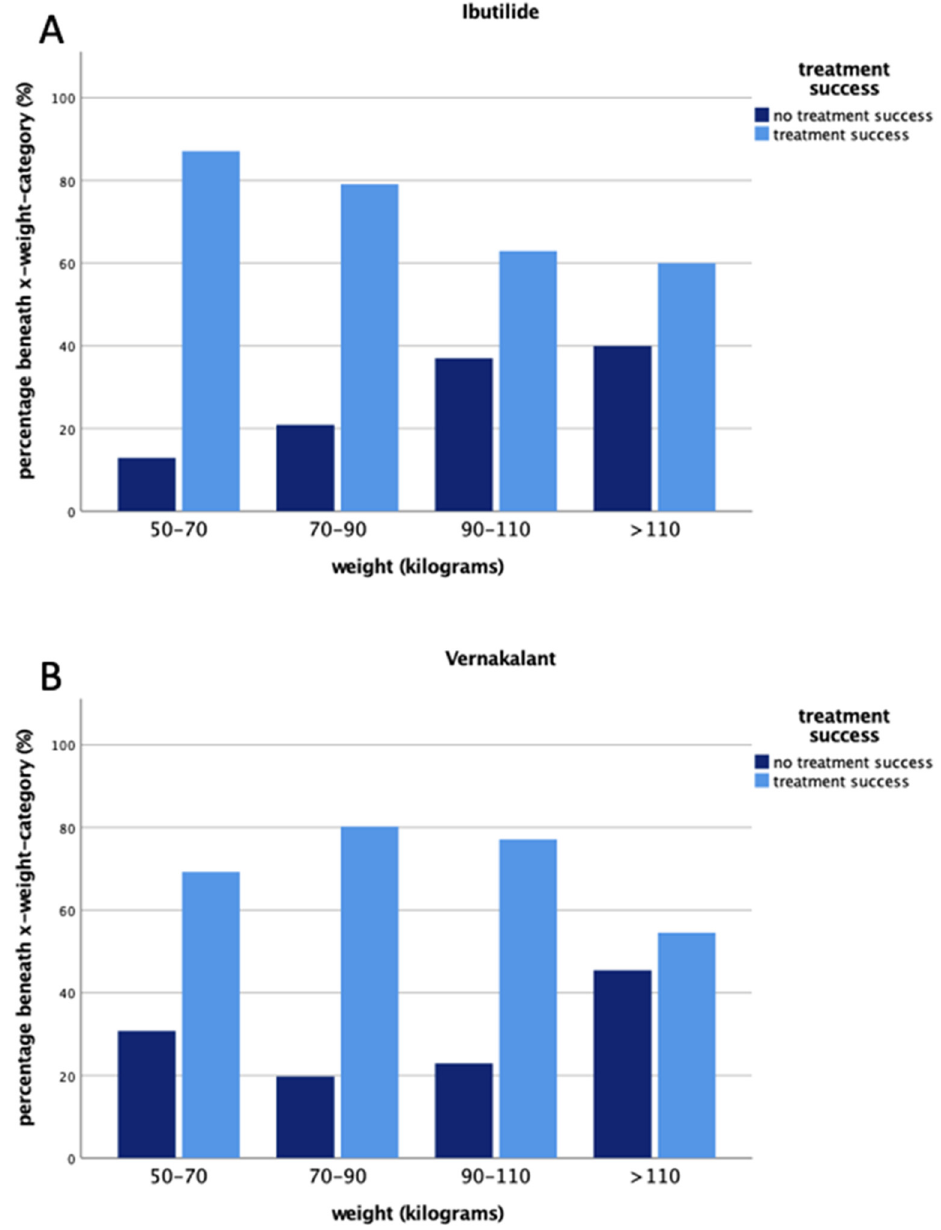
Figure A1. The interaction of treatment success and body weight in the Ibutilide ( A ) and the Vernakalant ( B ) subgroups.